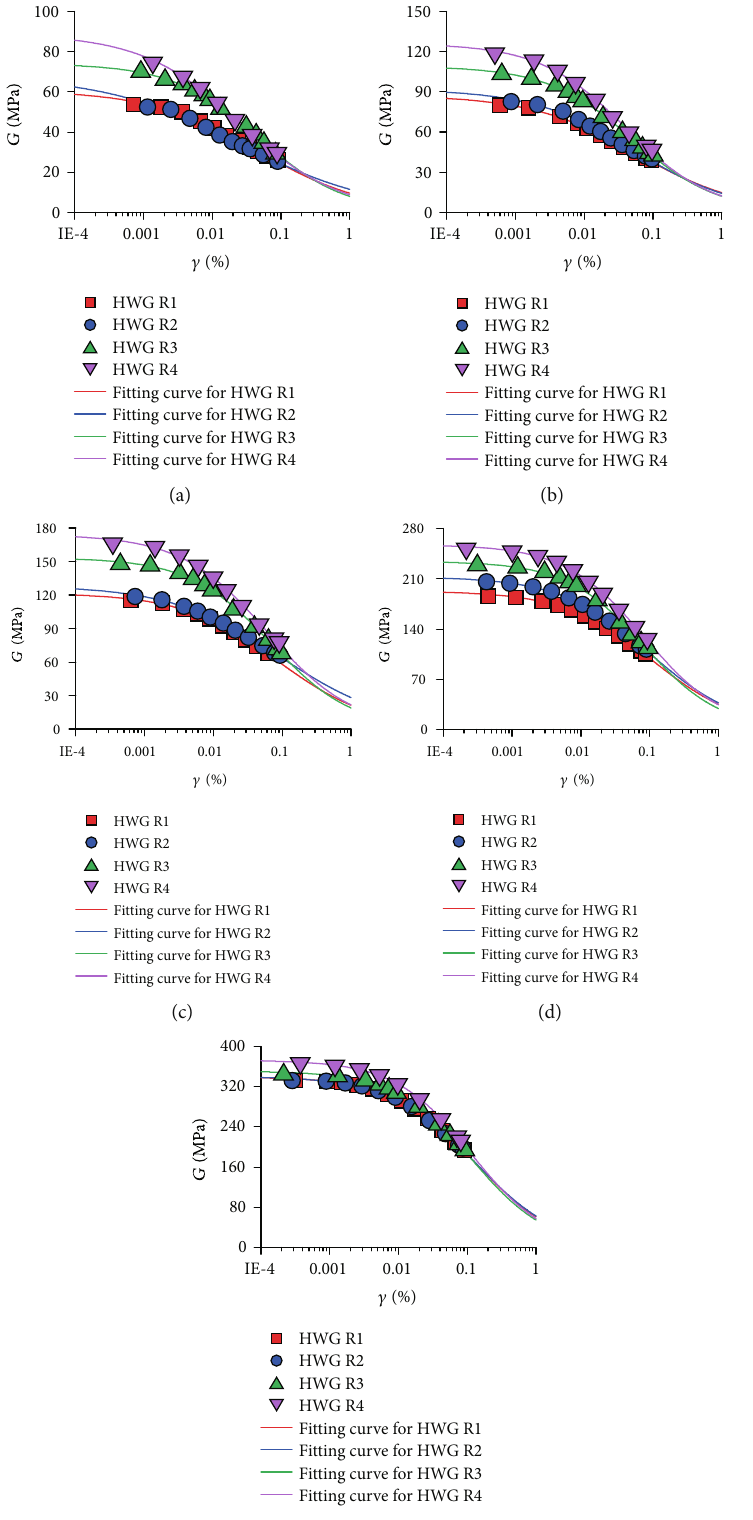
Figure 5: Variation in G with γ at various e ff ective consolidation stresses: (a) 50 kPa; (b) 100kPa; (c) 200 kPa; (d) 400kPa; and (e) 800kPa. (Data points